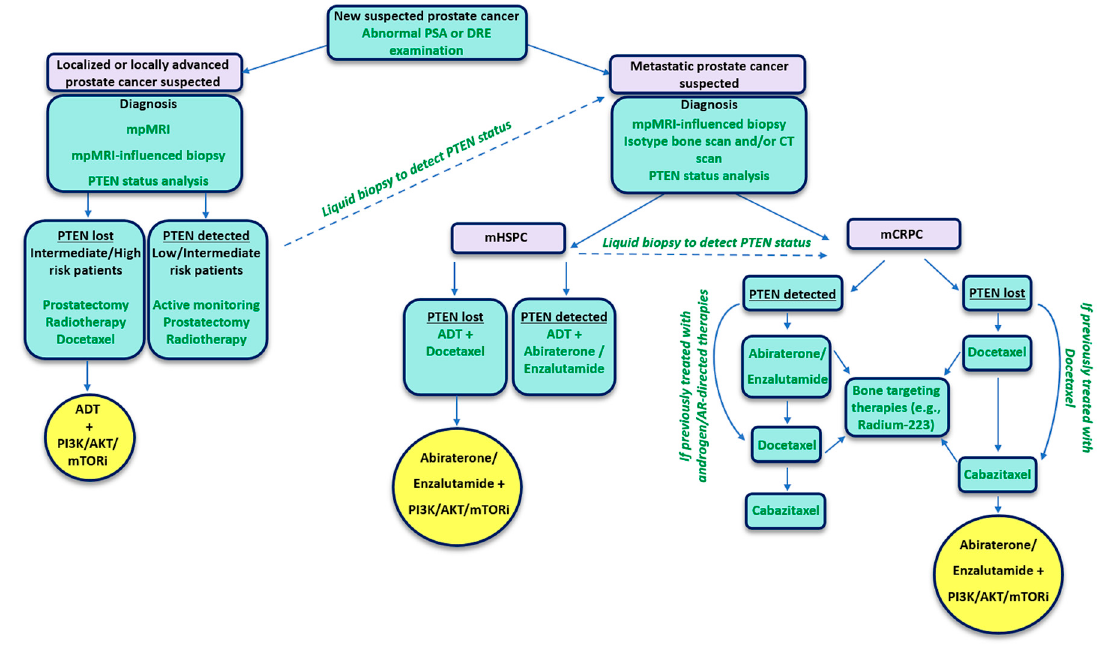
Figure 1. Tailoring treatments for local and metastatic prostate cancer based on PTEN status. Image shows hypothetical guidelines for diagnosing and treating prostate cancer following PTEN screening.